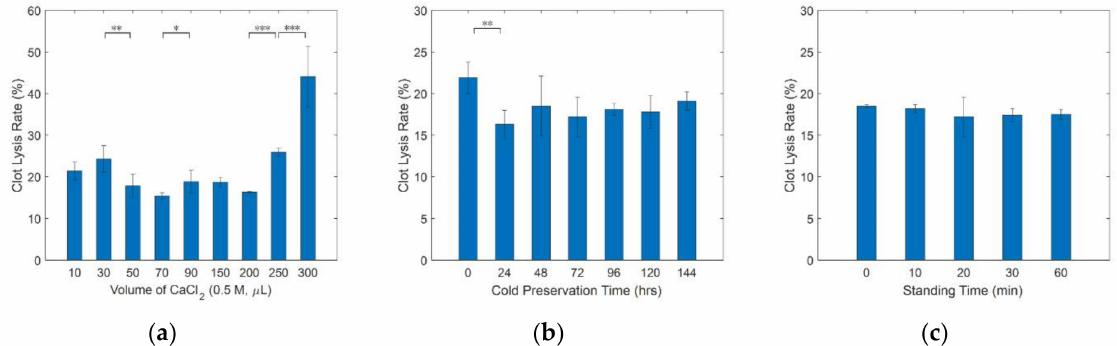
Figure 5. Mass reduction of bovine blood clots in static saline. ( a ) Clot lysis rate of clots prepared at each volume of CaCl 2 . Clots were exposed in saline for 60 min without storing at 5 ◦ C in advance ( n = 3). ( b ) Clot lysis rate for various cold preservation times. Clots formed with 70 µ L CaCl 2 were exposed in saline for 60 min ( n = 3). ( c ) Clot lysis rate over different standing times. Clots were prepared with 70 µ L CaCl 2 and stored in 5 ◦ C for at least 24 h before experiment ( n = 3, * p < 0.05, ** p < 0.01, *** p <